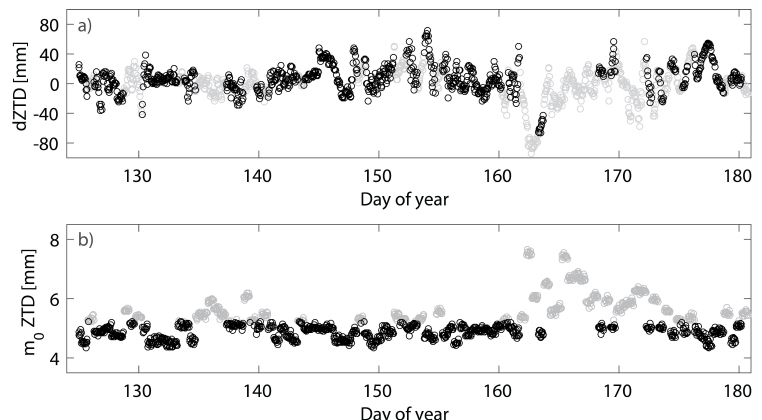
Figure 10. ( a ) ZTD differences between GNSS and ray-tracing. ( b ) Total combined uncertainties of ZTDs based on uncertainty of WRF refractivity field and GNSS formal errors. Black circles show observations within uncertainty threshold, whereas epochs that correspond to gray dots have been removed from the analysis.